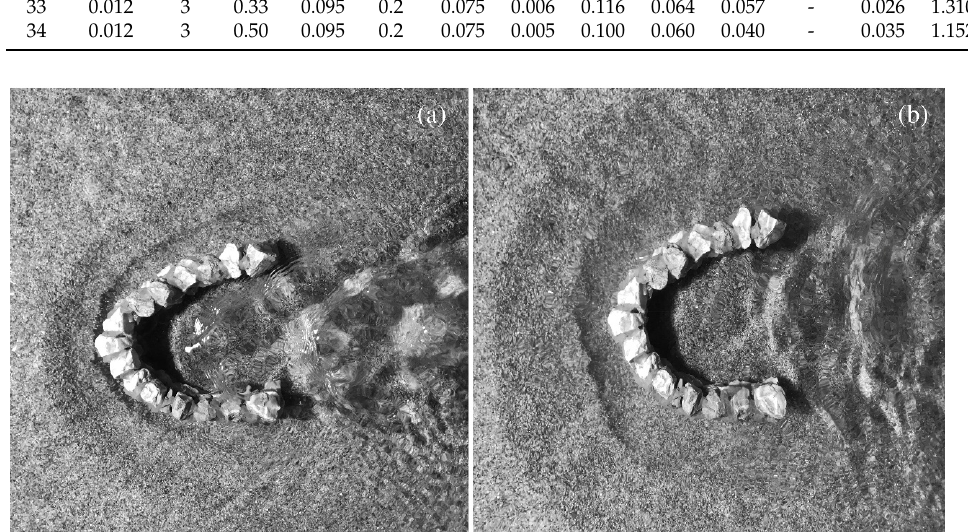
Figure 3. Scour evolution for test 6 at ( a ) t = 0 s (test beginning) and ( b ) t = 1800 s. Flow is from left to right.